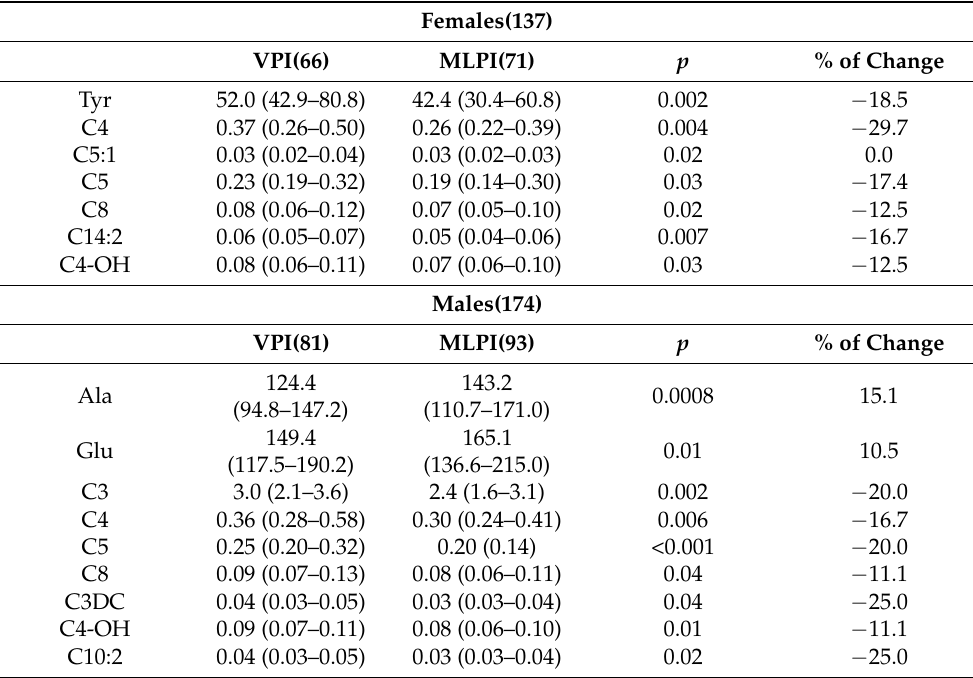
Table 2. Intra-sex analysis of GA effect in female and male preterm